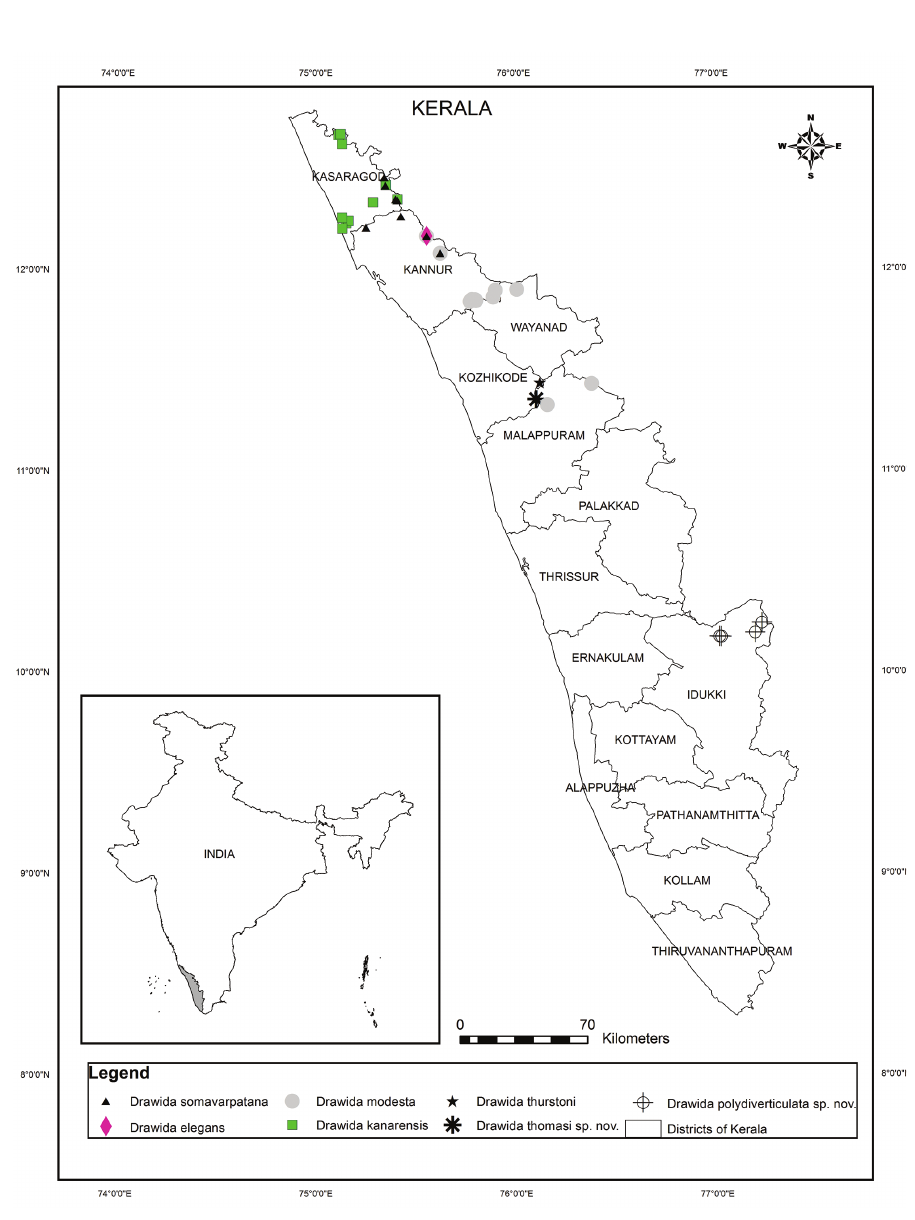
Figure 2. Distribution of newly described and reported Drawida species from Kerala.